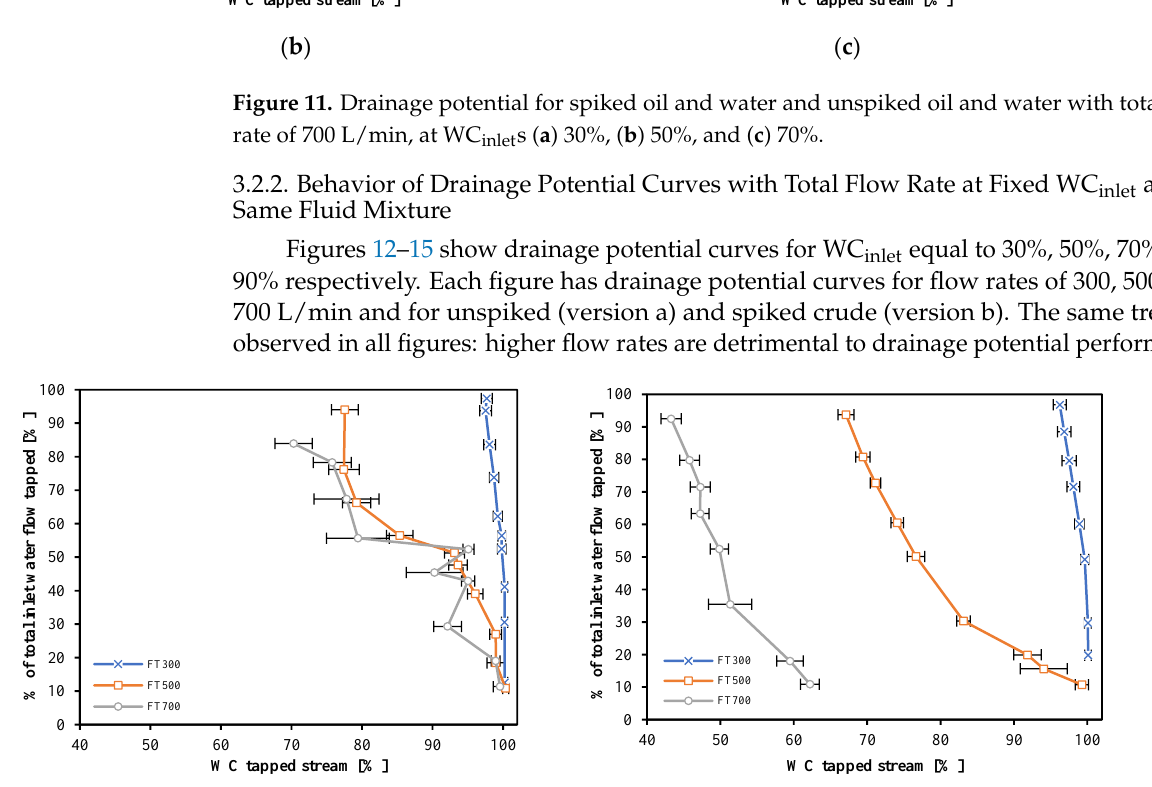
Figure 12. Drainage potential for ( a ) unspiked, ( b ) spiked oil and water at WC inlet 30%, total flow rate of 300, 500, and 700 L/min.